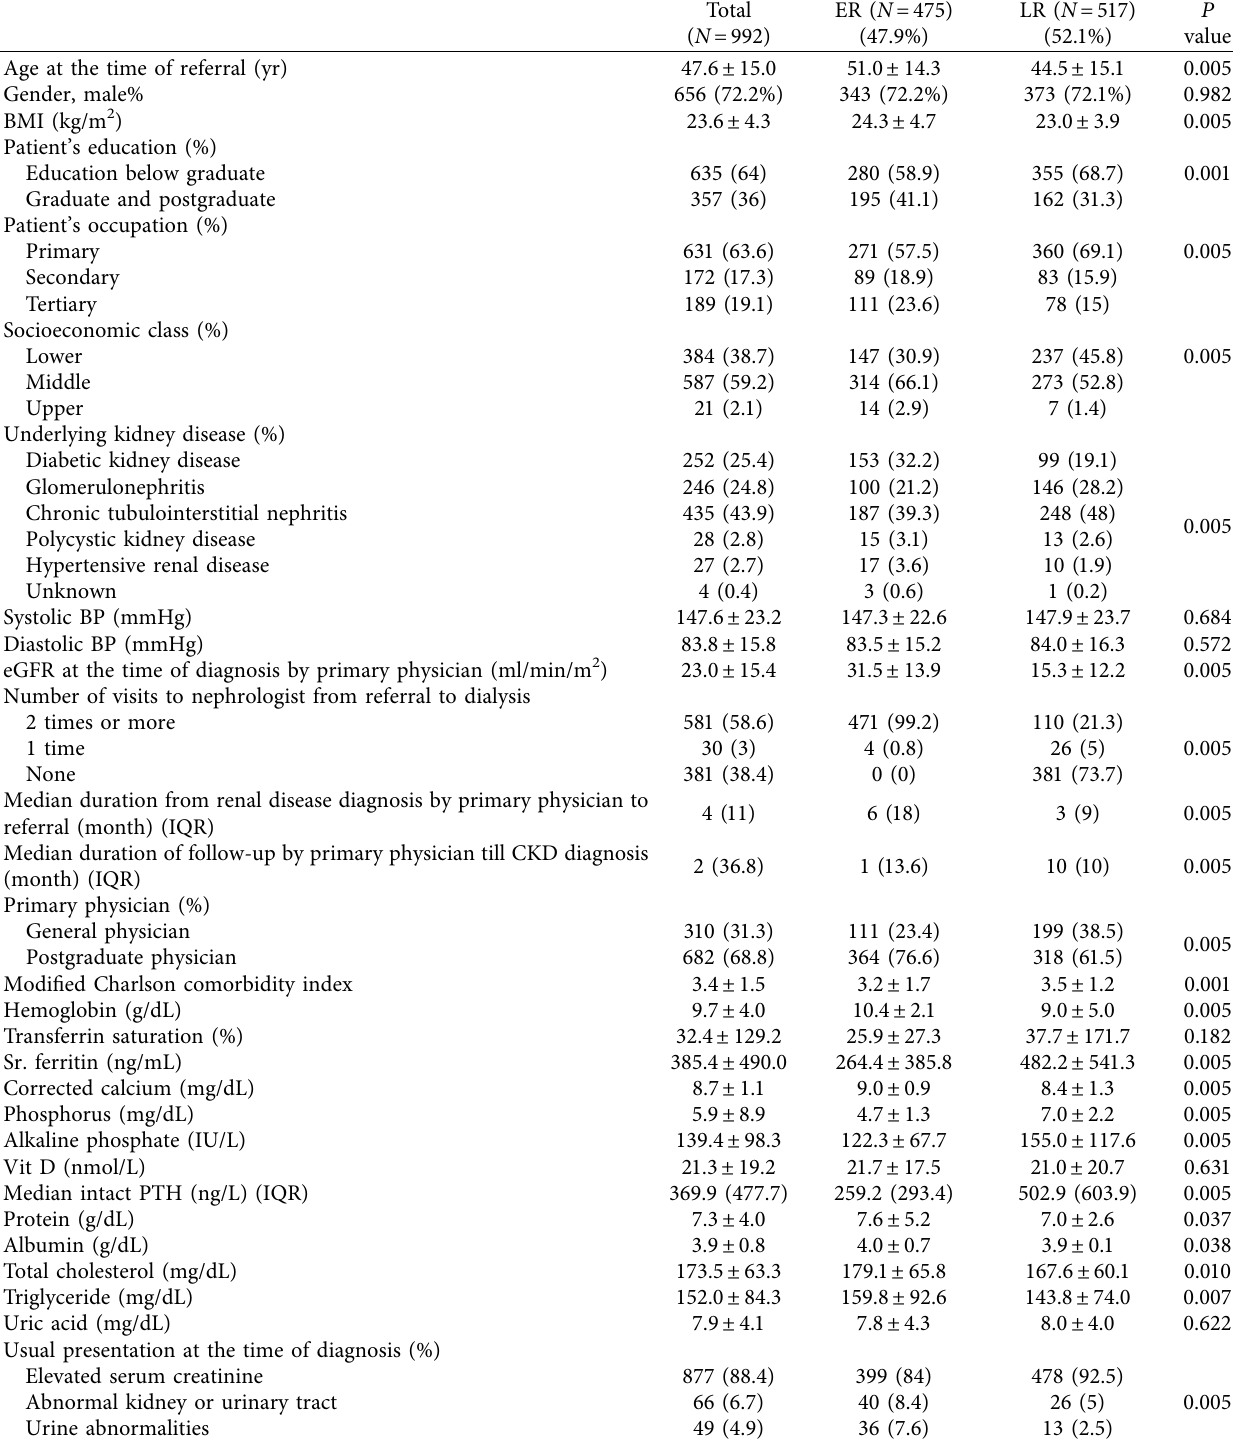
Table 1: Patient-related characteristics and analysis for referral